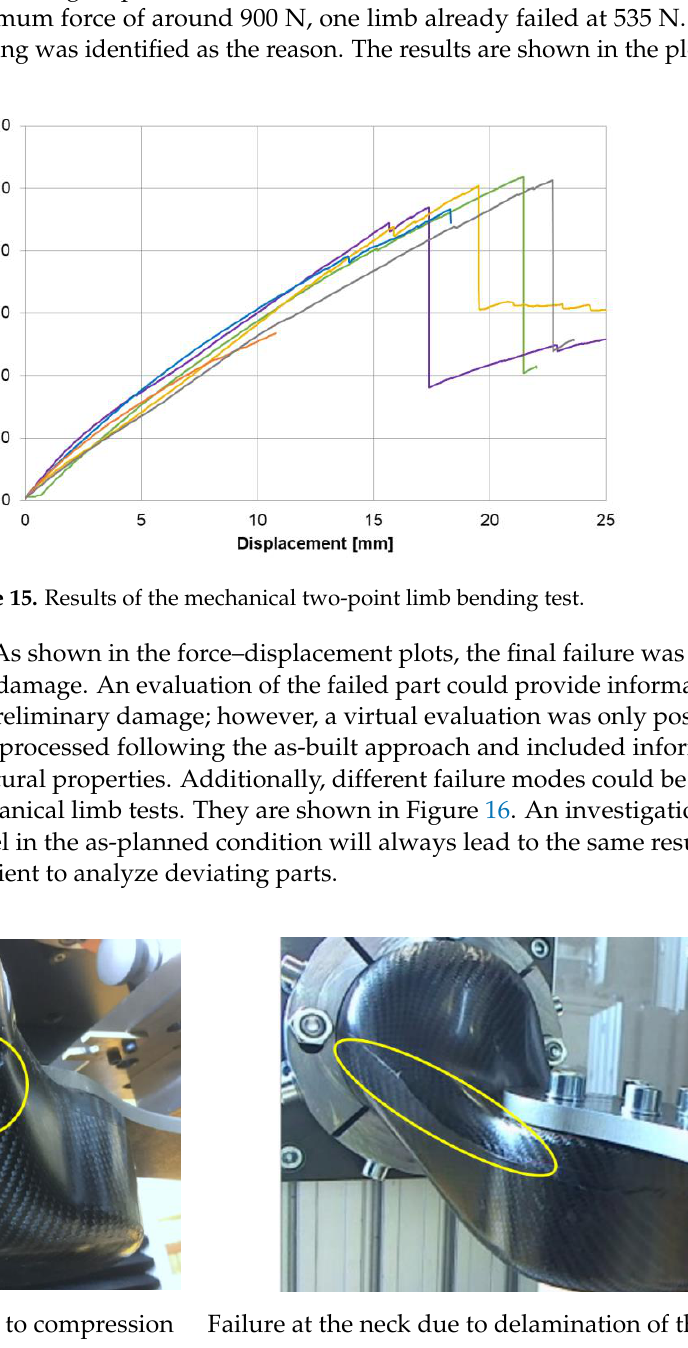
Figure 14. Comparison of the as-planned and two different as-built configurations.